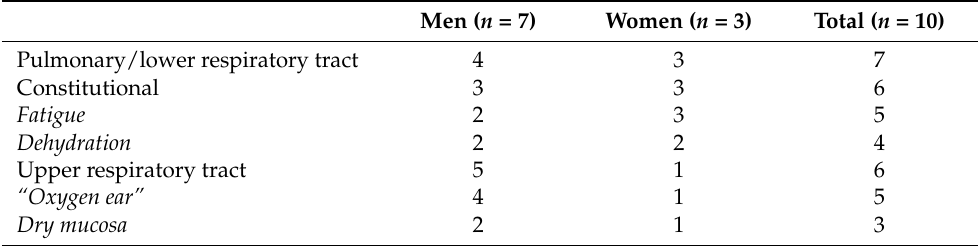
Table 2. Symptoms experienced by subjects after hyperbaric